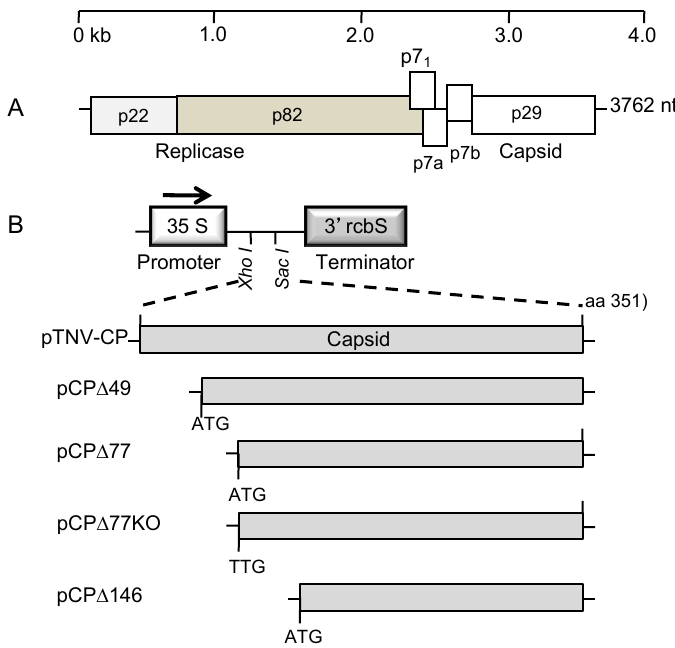
Figure 1. Genome organization of TNVD H , and TNV CP constructs used for transient expression in Nicotiana species. ( A) TNV-D H genome structure. The six open reading frames are illustrated by boxes. The p82 protein is highlighted in a different color from the p22 protein to emphasize that it is a readthrough product of the p22 protein. ( B) Structure of inserts into the Agrobacterium binary vector pKYLX7. The arrow indicates the direction of transcription of the 35S promoter. All TNV CP constructs were generated by PCR and delimited by Xho I and Sac I sites for cloning into pKYLX7. The clones pCP∆49, pCP∆77, and pCP∆146 utilized start codons present in-frame within the TNVD H CP coding sequence, and represent deletion of the first 49, 77 and 146 codons of the CP sequence, respectively. The clone pCP∆77KO, the start codon has been changed to TTG.